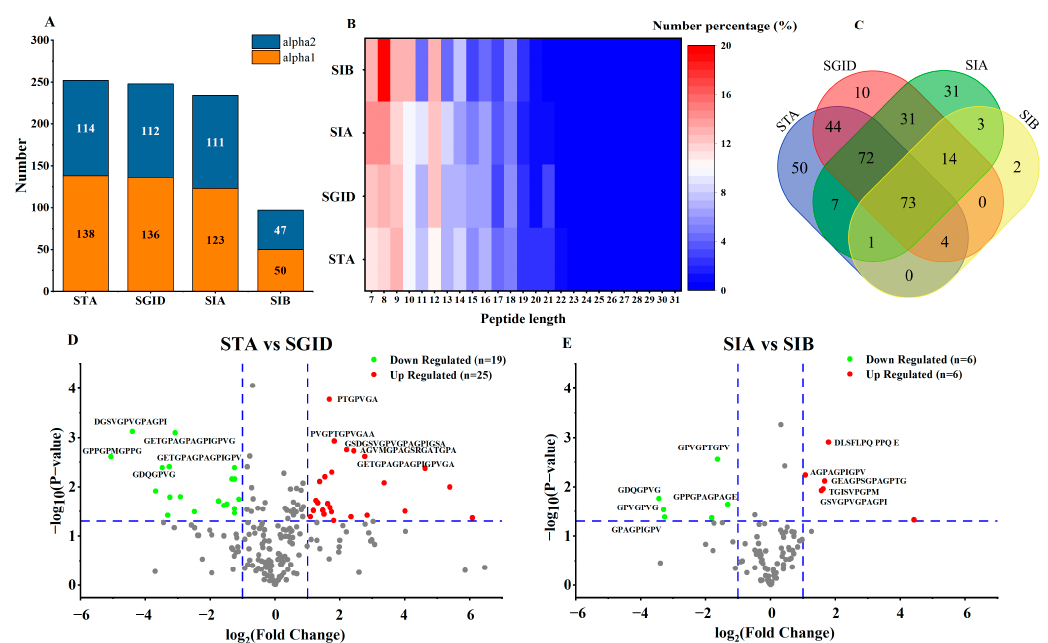
Figure 4. The identification of peptides. The number of peptides in each sample ( A ); The different percentages of peptides with different peptide lengths in each sample, Number percentage ( % ) = × 100% , where X is the peptide length of the peptides ( B ); The uniqueness and repeata- bility of peptides in each sample are displayed by the Venn diagram ( C ); The upregulated or downregulated peptides when comparing STA with SGID ( D ) and comparing SIA with SIB ( E ). STA: start digestion samples; SGID-X: samples during simulated digestion and absorption, X is the time (h); SIA: samples on the apical side of the transwell cell; SIB: samples on the basolateral side of transwell cell.